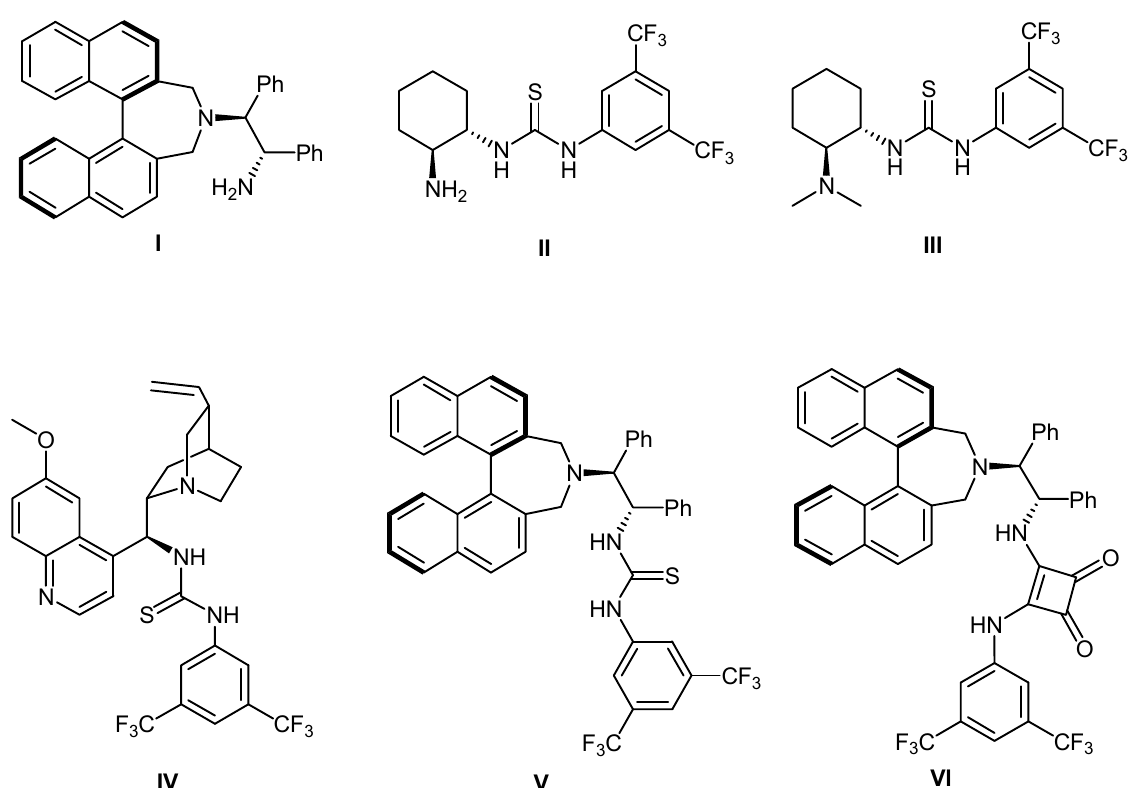
Figure 1. Structures of various chiral